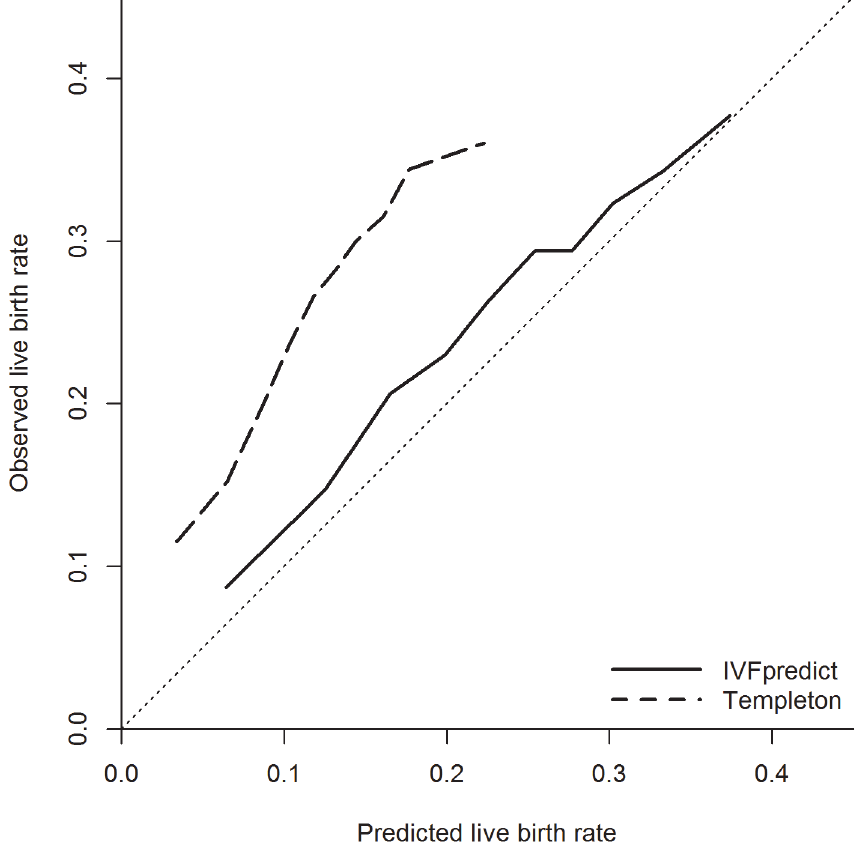
Fig 2. Calibration plot for the IVFpredict and Templeton models. Based on 130,960 IVF cycles. Hosmer- Lemeshow test statistics: p < 0.001. Solid line, IVFpredict model; dashed line, Templeton model; dotted, diagonal line, perfect prediction